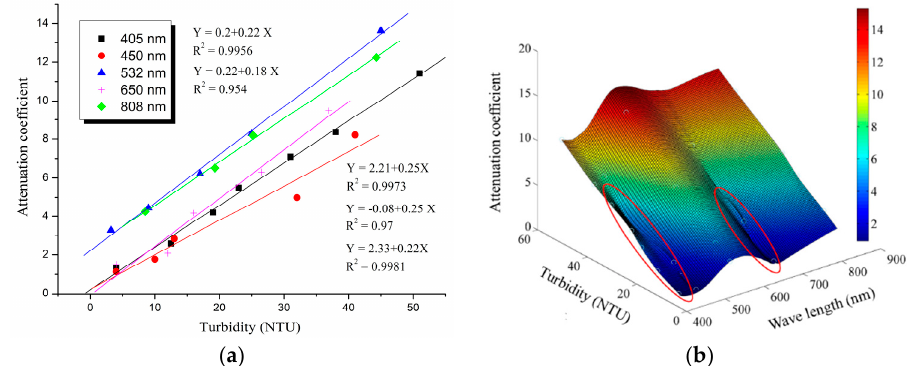
Figure 3. Attenuation coefficient—turbidity curve in dissolution medium of CaCO 3 : ( a ) Two dimension; ( b ) Three dimension